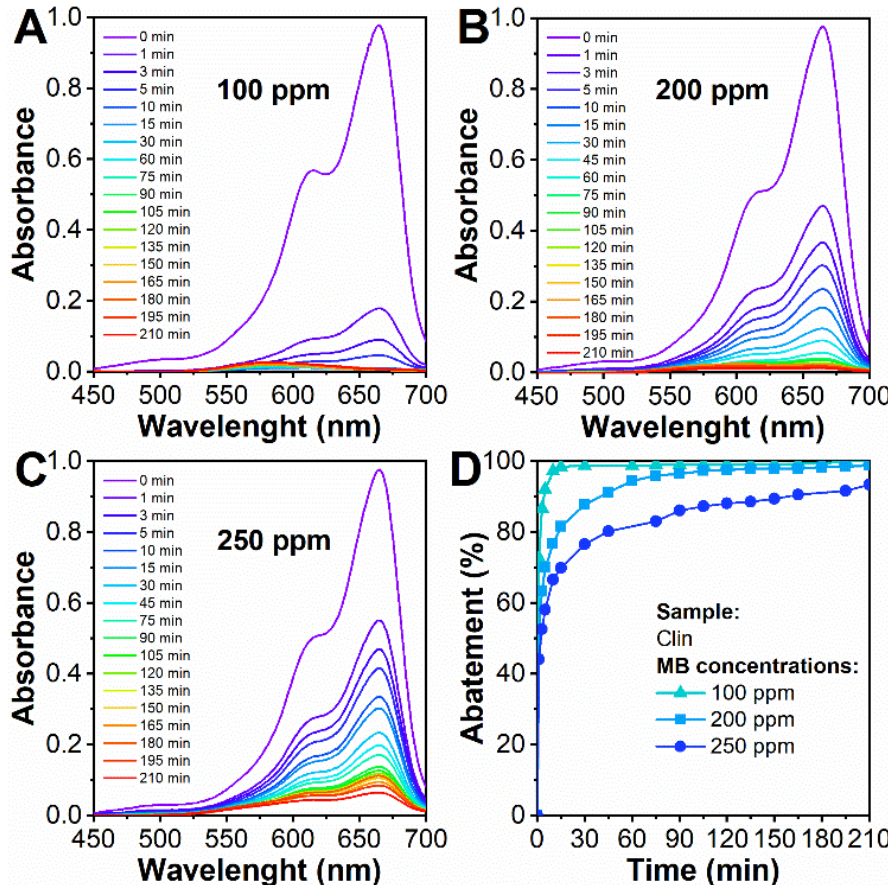
Figure 4. Clin (5 g L − 1 ) abatement tests were performed with 100 ppm ( A ), 200 ppm ( B ), and 250 ppm ( C ) MB concentrations. MB abatement as a function of time ( D ) at three concentrations, 100, 200, and 250 ppm. Table 3. pH values at the beginning (t = 0 min) and the end (t = 210 min) of MB abatement